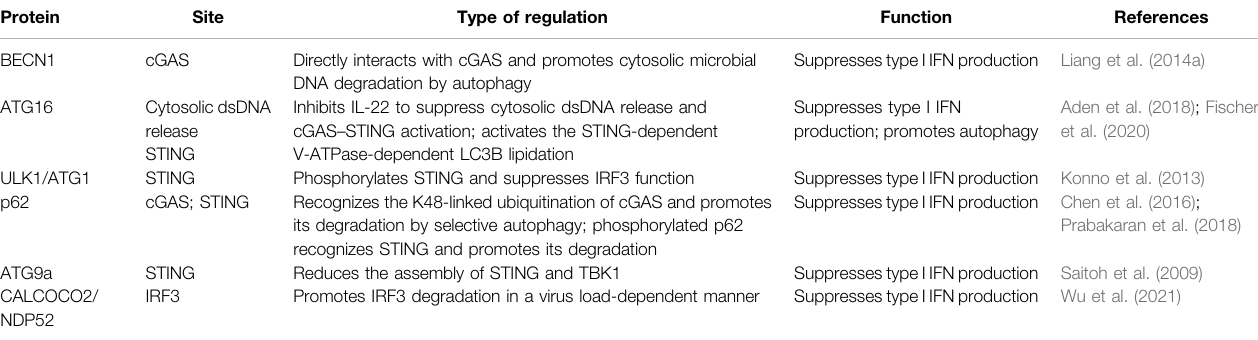
TABLE 1 | Regulation of transcription of genes involved in cGAS – STING signaling by autophagy proteins.